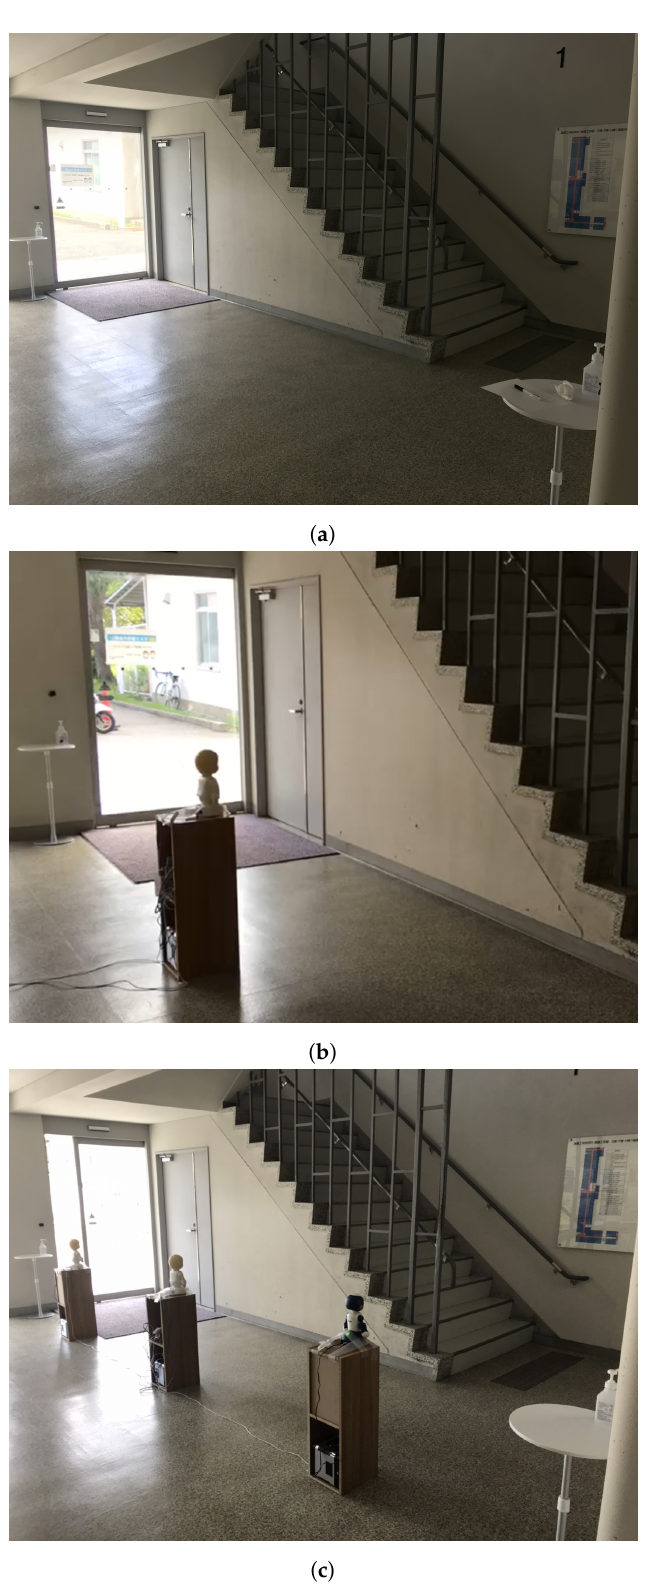
Figure 7. D entrance of the building of the Graduate School of Engineering Science in Osaka University during the experiment for the scenarios: ( a ) 0 robots; ( b ); 1 robot ( c ); 3